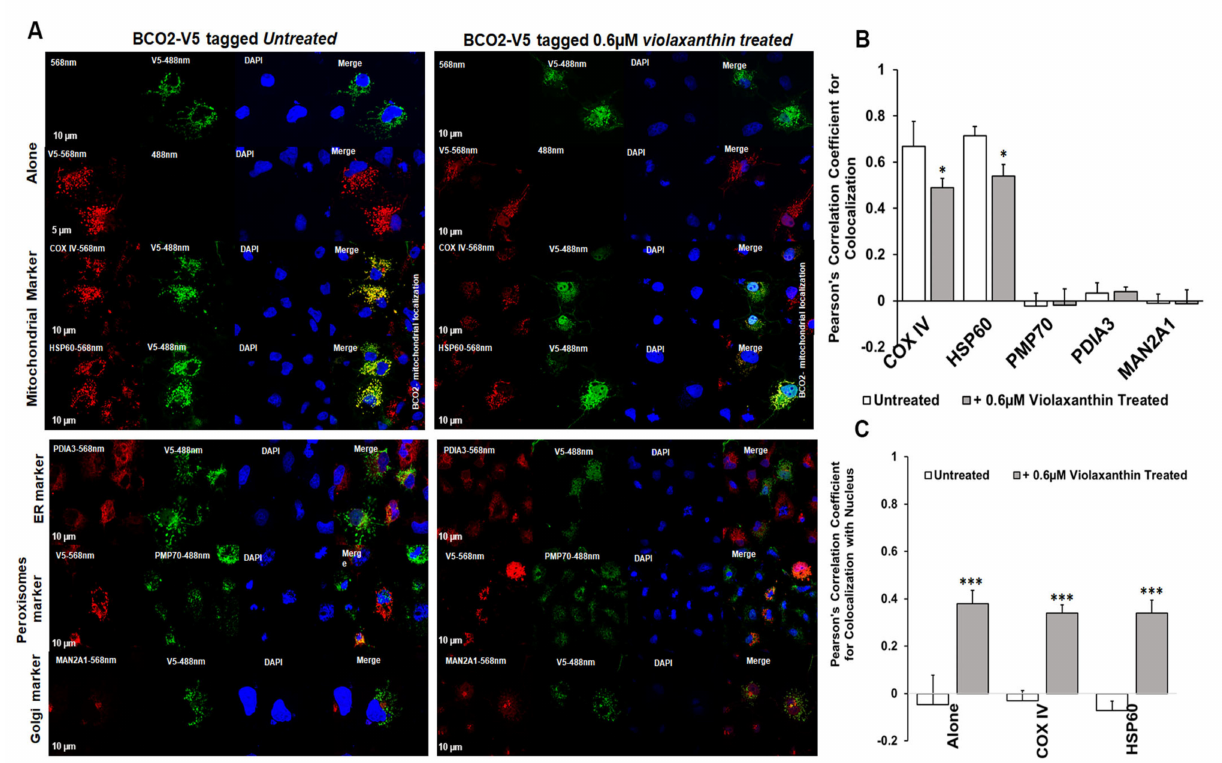
Figure 5. Characterization of subcellular localization of mBCO2 treated with violaxanthin. ( A ) COS7 cells expressing mBCO2 protein treated with 0.6 µ M violaxanthin for 5 h were immunoassayed using antibodies against V5 tag and different organelle marker proteins as indicated in the Materials and Methods section. Pearson’s correlation coefficients were calculated for colocalization of V5-tagged mBCO2 protein with different organellar marker proteins ( B ) and with nucleus ( C ); * p ≤ 0.05; *** p ≤